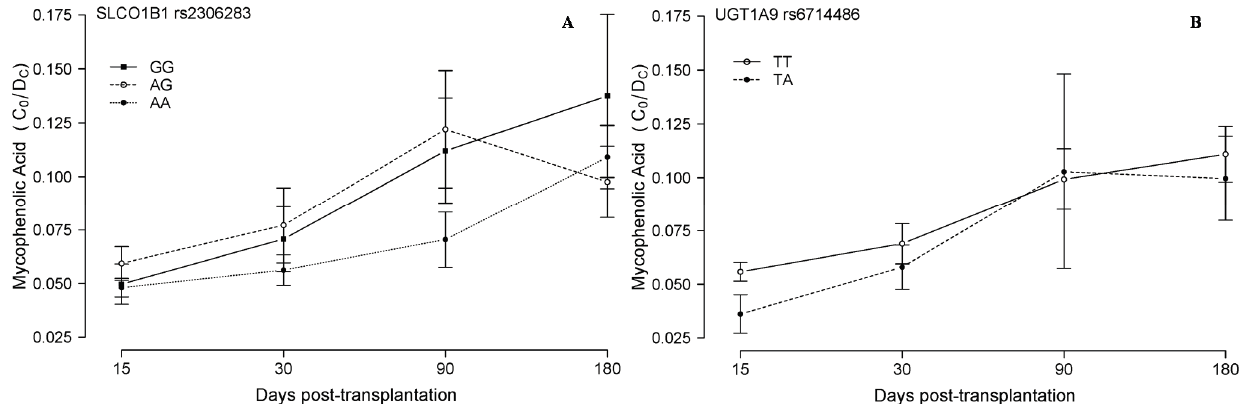
Figure 4. Mycophenolic acid blood concentration in relation to other associated SNPs. Mycophenolic acid corrected (dose/weight) trough concentrations (C 0 /D c , ((ng/mL)/(mg/kg/ 24 h))) are plotted (mean and standard deviation of all the measurements in each period) in relation to the SLCO1B1 rs2306283 ( A ) and the UGT1A9 rs6714486 ( B ) genotypes of 51 lung transplanted patients, during the first six months